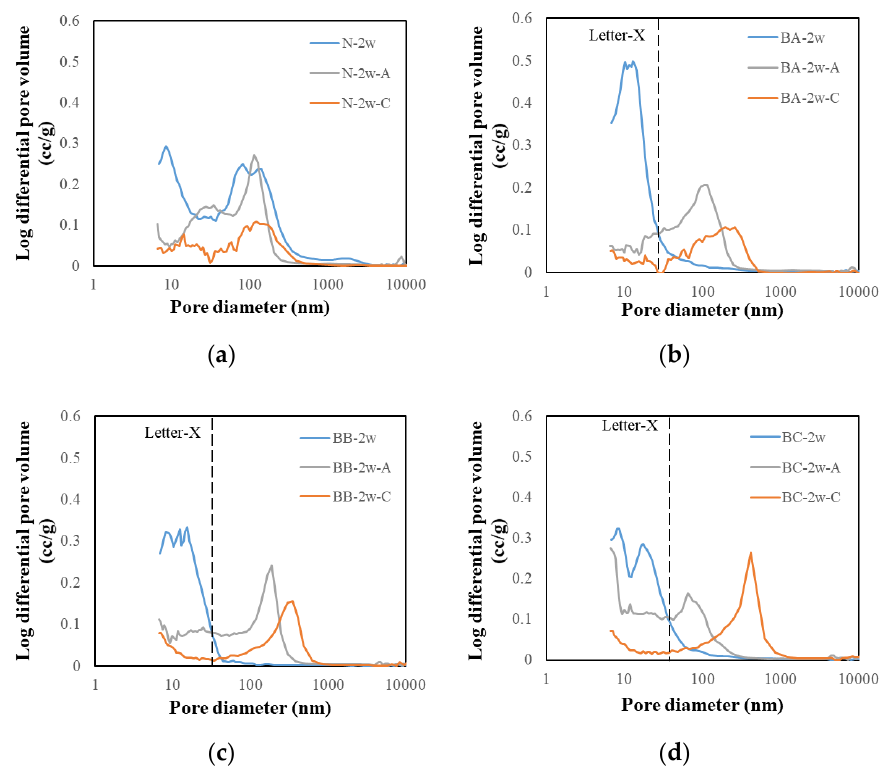
Figure 7. Pore size distributions of carbonated cement paste. ( a ) N; ( b ) BA; ( c ) BB and ( d ) BC.